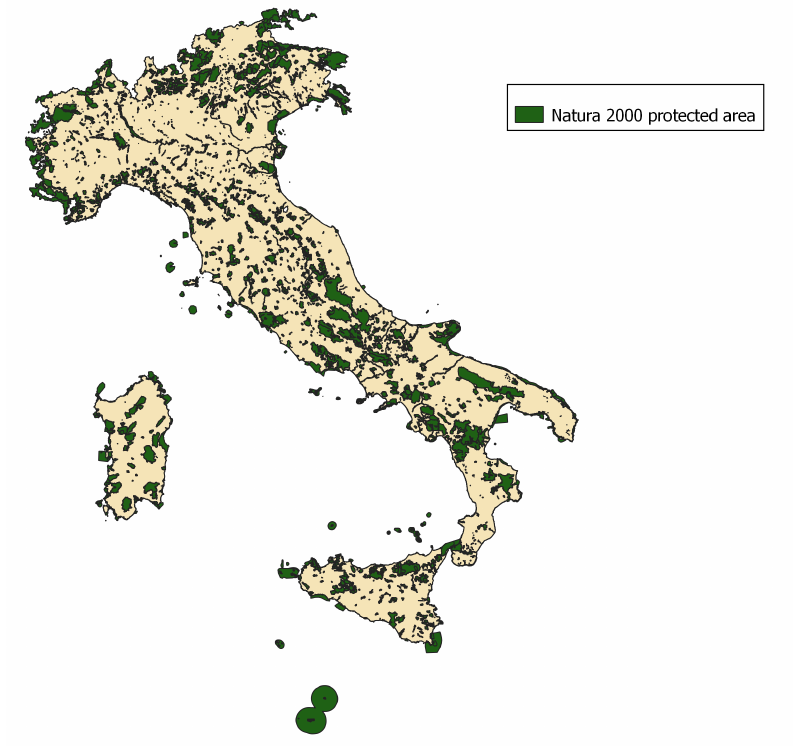
Figure 2. Spatial distribution of Natura 2000 protected areas in Italy. Italy’s varied geological structure contributes to its high climate and habitat diversity. The Italian peninsula is located at the center of the Mediterranean Sea, forming a corridor between central Europe and North Africa, with a total of 8000 km of coastline.